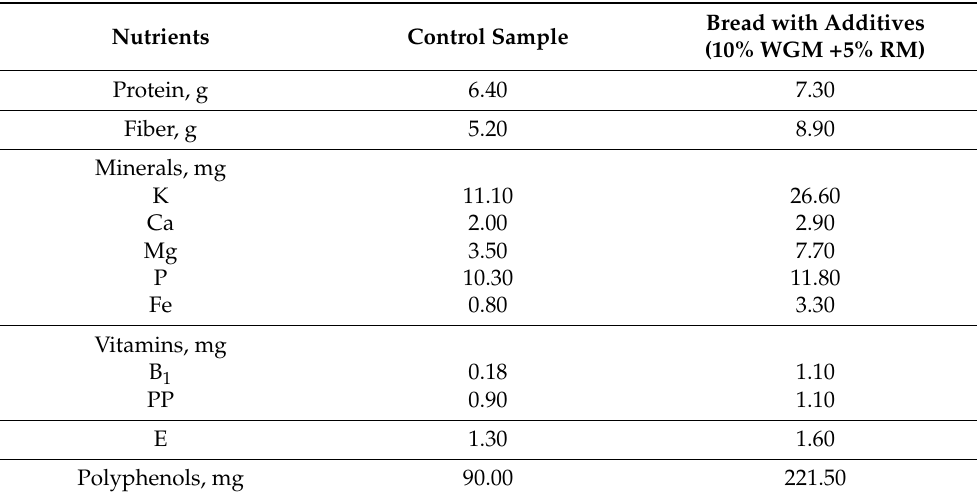
Table 2. The effect of wheat germ meal (WGM) and rosehip meal (RM) on the nutritive value of rye–wheat bread.